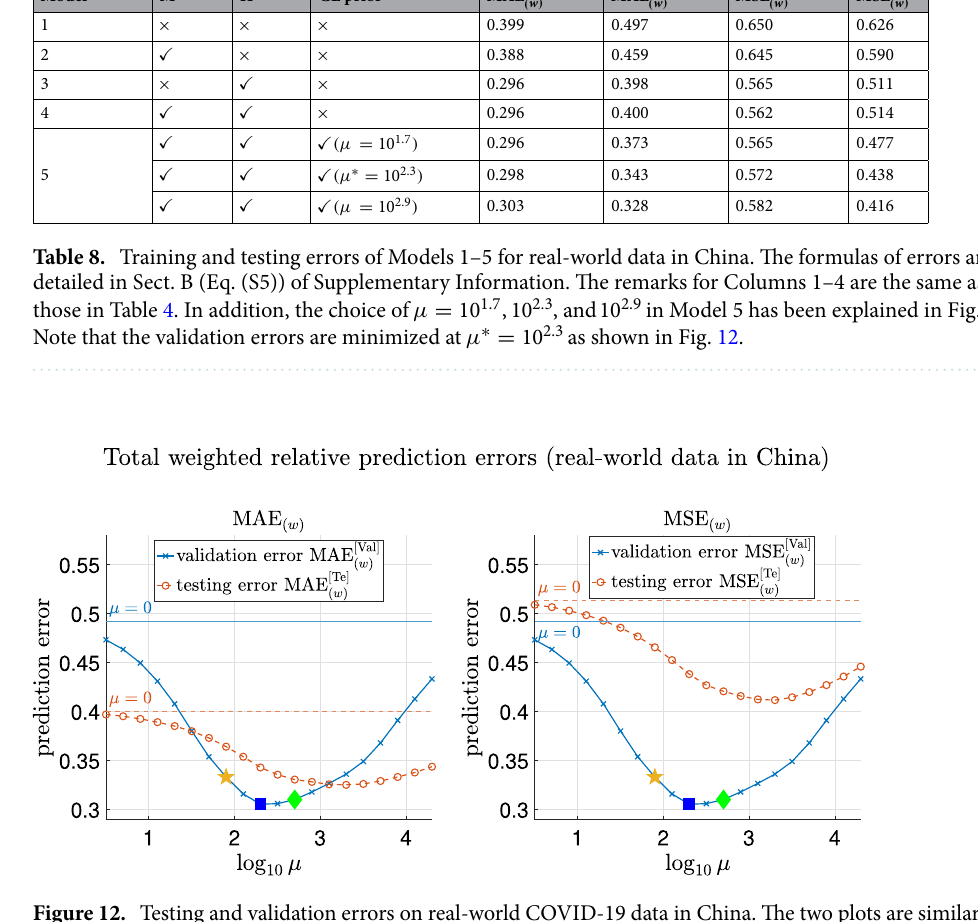
Figure 12. Testing and validation errors on real-world COVID-19 data in China. The two plots are similar to those in Figure 7, with errors computed on the real-world data in China instead of simulated data. Both the MAE and MSE validation errors are minimized at µ = 10 2.3 , which is marked by blue squares in both plots. µ = 10 1.9 and 10 2.7 are chosen by perturbing the minimizer µ = 10 2.3 , have slightly larger validation errors, and are marked with yellow pentagrams and green diamonds in both plots. The construction of training/validation/ testing data is detailed in Sects. A.1.2 and D of Supplementary